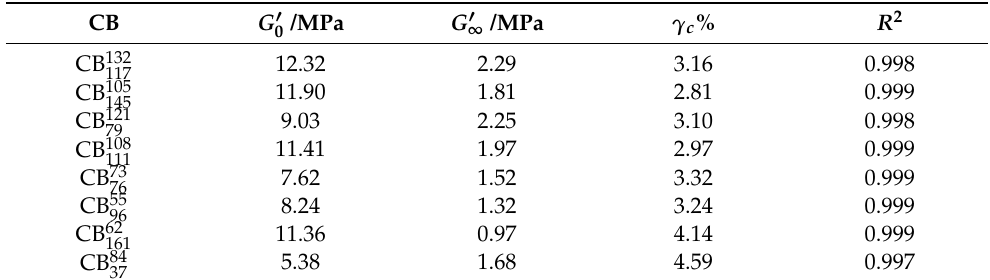
Table 6. Fitting of G (cid:48)(cid:48) ( γ ) according to Equation (9) where the value of m has been assigned as 0.55. CB G (cid:48)(cid:48) m /MPa γ c % ∆ G (cid:48)(cid:48) 1.21 2.85 0.65 0.24 0.996 CB 132 117 CB 105 145 0.73 0.82 CB 55 96